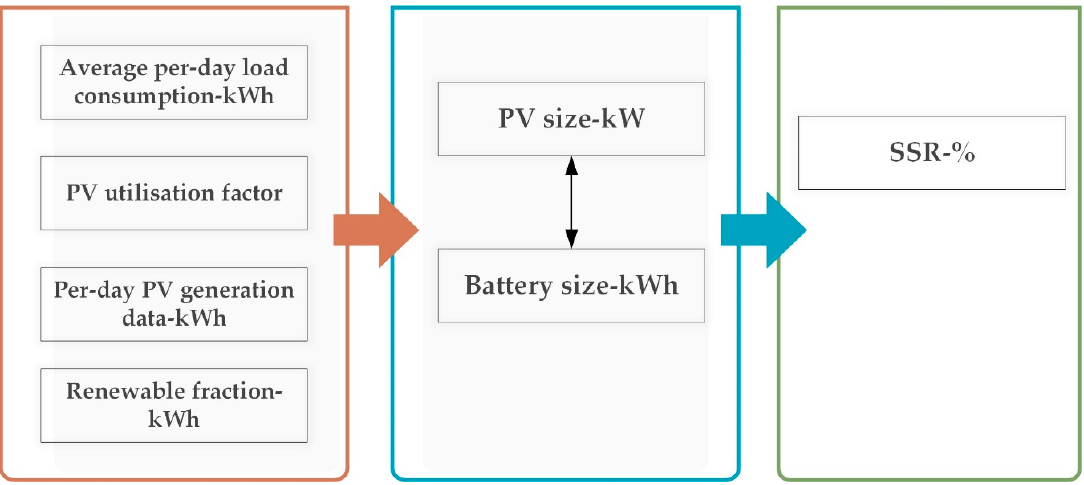
Figure A2. Estimation process of varying battery sizes on SSR.